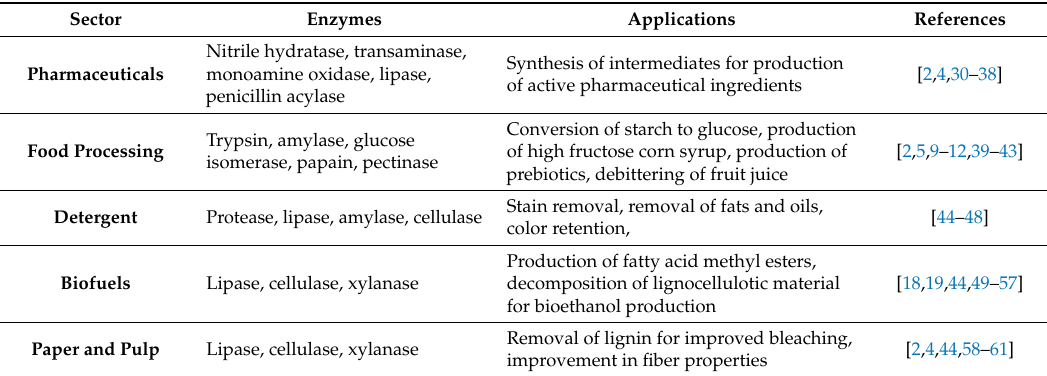
Table 1. Industrial applications of enzyme